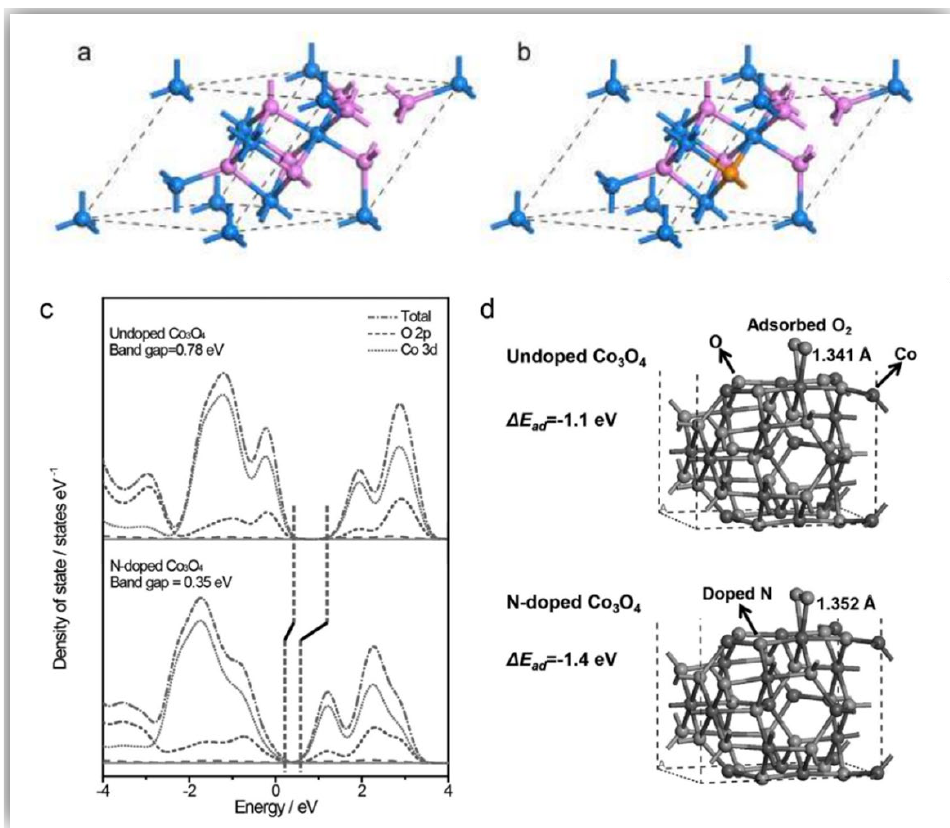
Figure 7. Density functional theory calculation of electronic structure and oxygen adsorption energy before and after N-doping Co 3 O 4 [80]. ( a , b ) The primitive cells of undoped Co 3 O 4 and N-doped Co 3 O 4 used to calculate the density of states, ( c ) DOS of Co 3 O 4 and N-Co 3 O 4 , ( d ) Calculated structures and O 2 -adsorption energies ( ∆ E ad ) of the undoped and N-doped Co 3 O 4 (110) surfaces. Reprinted with permission from Ref. [80]. Copyright © 2017 Wiley-VCH Verlag GmbH & Co. KGaA,